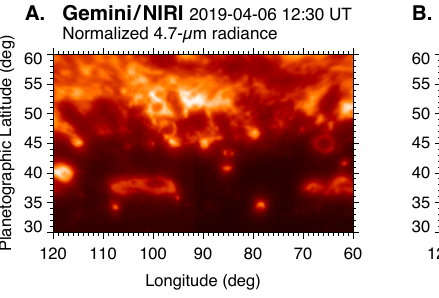
Figure 20. Modulation of infrared thermal emission over the map range is well described by PCs 1 and 3, supporting the interpretation that these PCs map to upper and lower cloud opacity. ( A ) The Gemini/NIRI 5-µm map is fully independent of the PC maps derived only from HST data. ( B ) PC1 (also shown in Figure 19G) is interpreted to represent τ haze . Comparison with panel ( A ) supports the idea that the infrared-bright northern high latitudes are a result of about a factor of two decrease in upper cloud/haze opacity. ( C ) PC3 (also shown in Figure 19I) is interpreted to represent τ cloud . Low PC3 amplitude in this panel corresponds well to isolated bright features in panel ( A ), suggesting that the bright features indicate holes in the lower cloud layer. The results are consistent with work from more than 50 years ago, which interpreted spatial variation in 5-µm imaging observations to be a result of varying opacity in a more uniform middle cloud layer and a patchier deep cloud layer [53,54,134,135]. The correlations are weaker in the upper right corner of the map, which is at high incidence angle for the HST observations ( µ 0 < 0.5; Figure